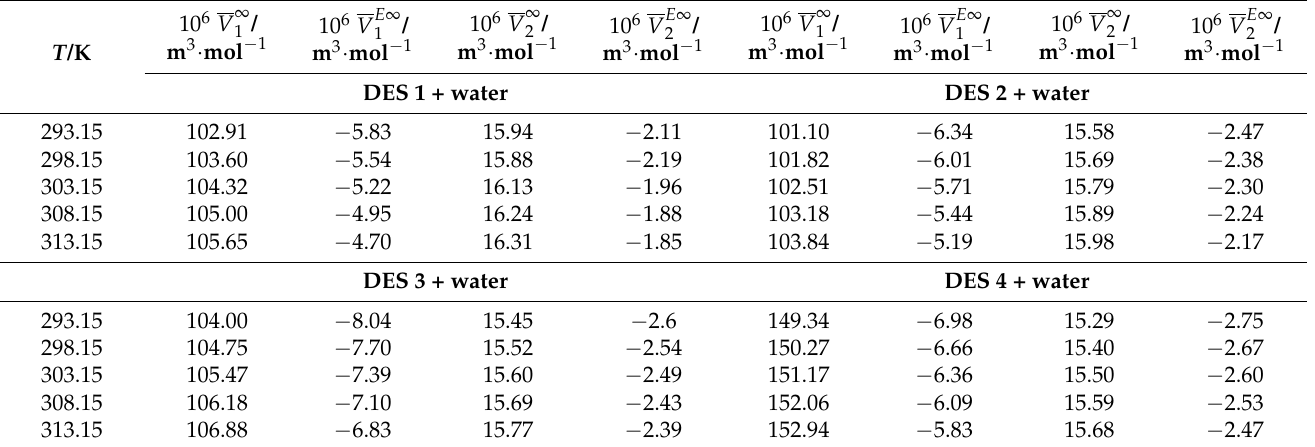
Table 4. Partial molar volumes at infinite dilution of DES and water in their binary mixtures at T = (293.15 to 313.15) K and at atmospheric pressure (0.1